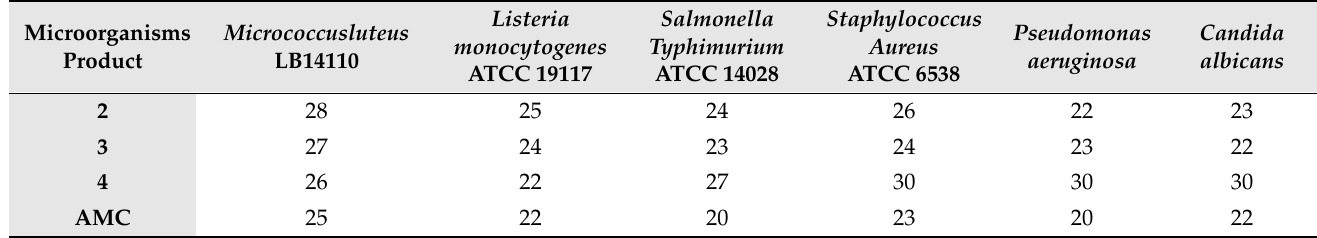
Table 8. Zone of bacterial inhibition measured in mm of the synthesized compound 2 – 4 .